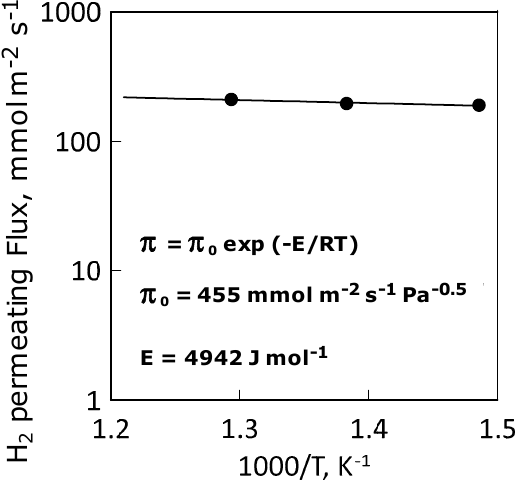
Figure 10. Hydrogen flux as a function of Sieverts’ driving force at different temperatures.